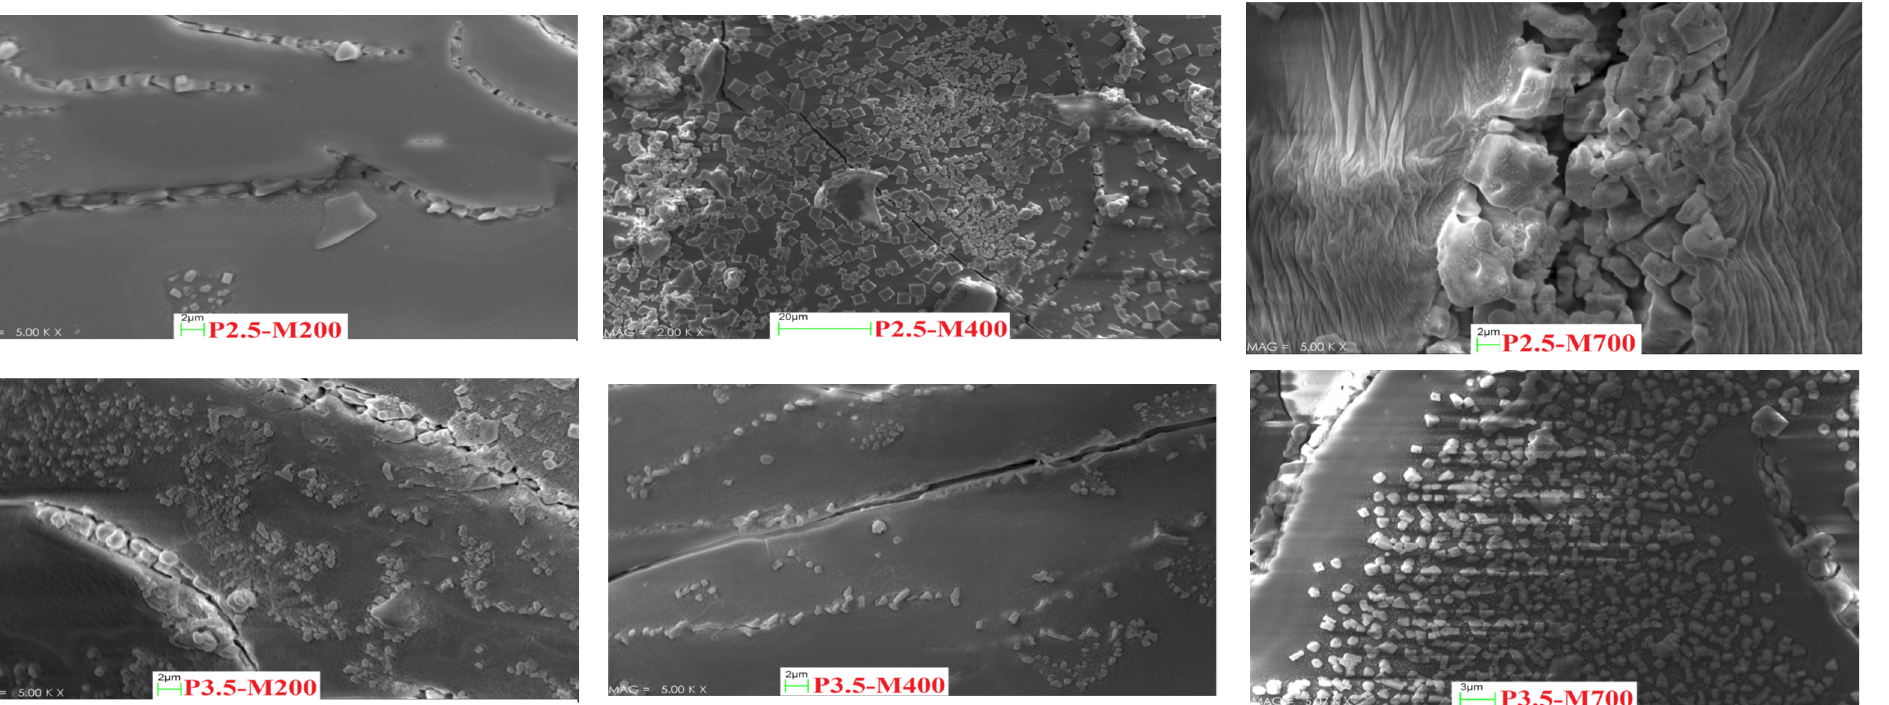
Figure 9. Scanning electron microscopy (SEM) of egg white powder treated with different phosphorylation (%) and microwave powers (W).